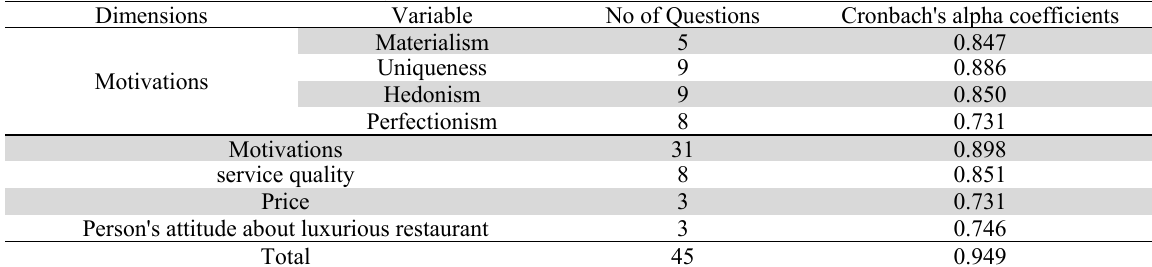
Calculation of variables'